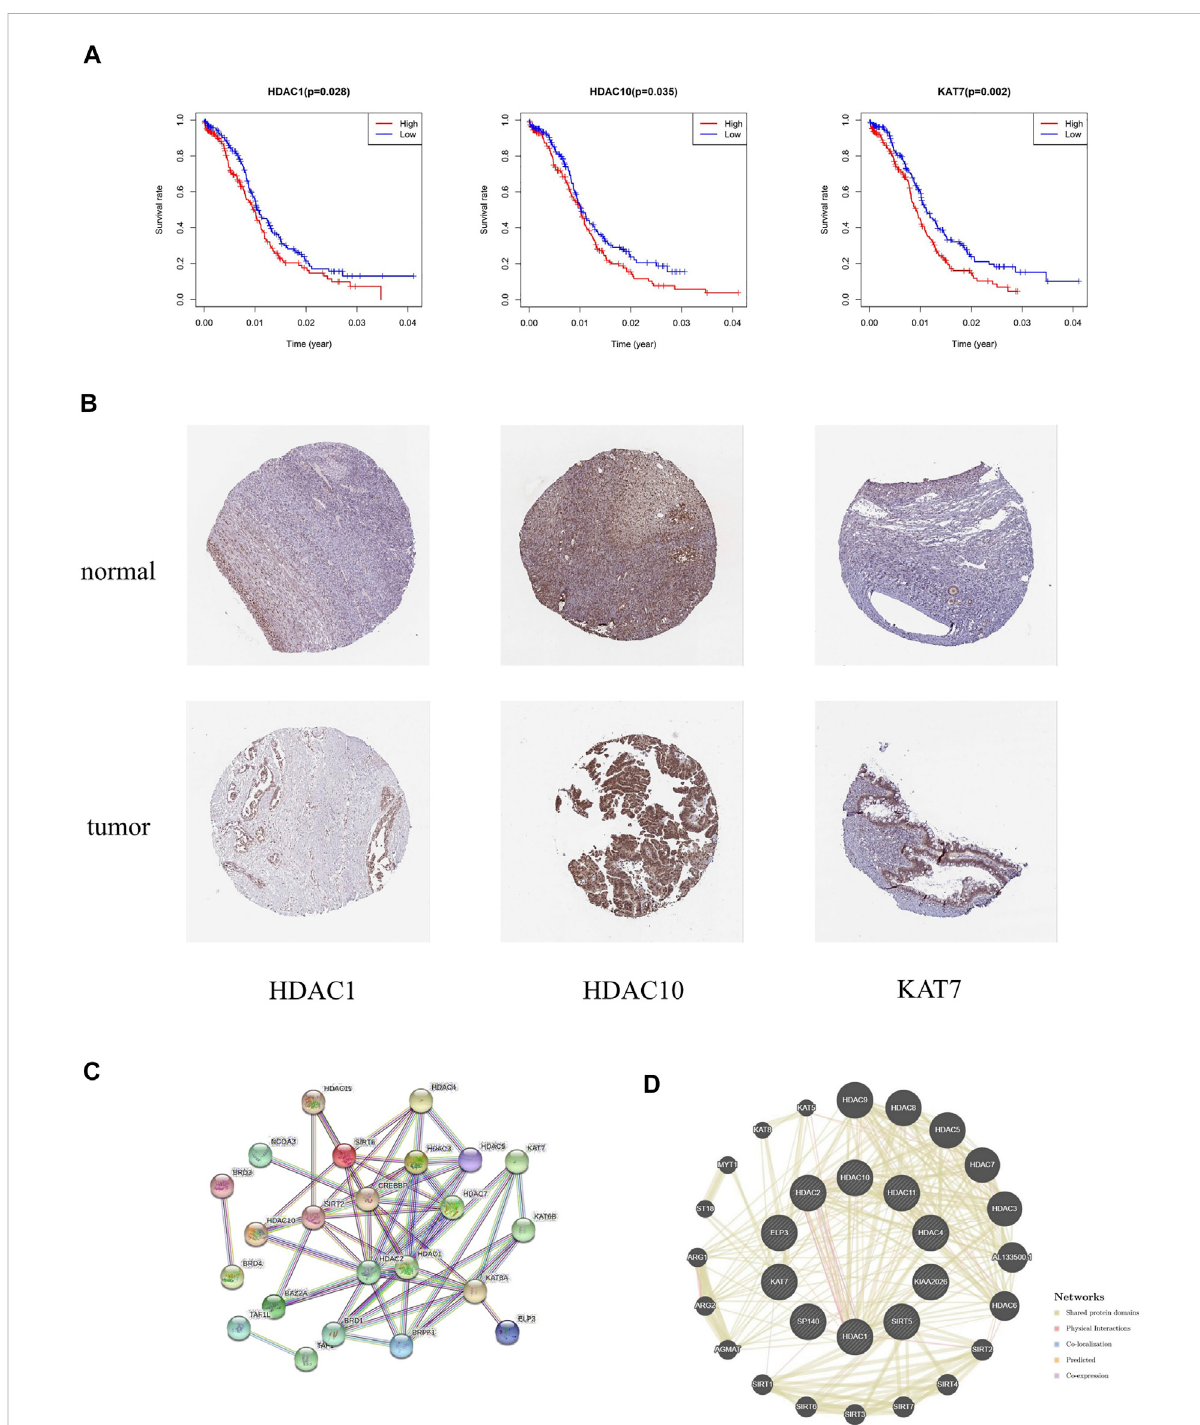
FIGURE 9 (A) Kaplan – Meier survival curves revealed contrasting survival possibilities predicted by varying expression of signature genes. (B) Protein expression of crucial HAMs in ovary cystadenocarcinoma serous and normal ovary tissues based on the HPA database (HDAC1 tumor: HPA029693, staining: medium, quantity: > 75%; HDAC1 normal: CAB068191, staining: medium, quantity: > 75 – 25%; HDAC10 tumor: CAB045977, staining: medium, quantity: > 75%; HDAC10 normal: CAB045977, staining: high, quantity: > 75%; KAT7 tumor: HPA044470, staining: medium, quantity: 75 – 25%; KAT7 normal: HPA044470, staining: medium, quantity: > 75 – 25%). (C,D) PPI network of prognostic HAMs. (C) PPI network by the STRING database. (D) Protein interaction analysis by the geneMania